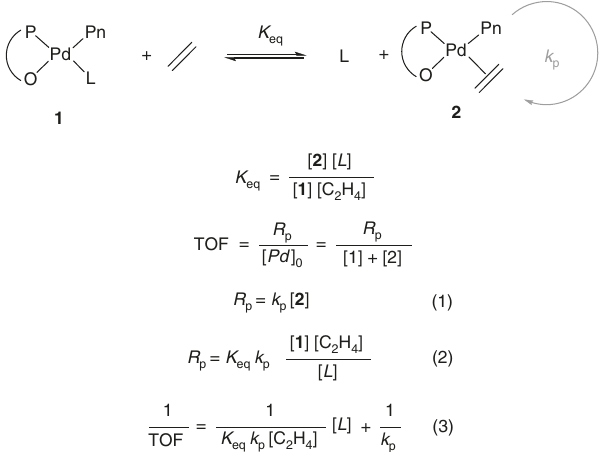
Fig. 5 Derivation of rate of polymerization assuming a fast and reversible pre-equilibrium. Equation (3) highlights the linear dependency of the inverse TOF as a function of the concentration of L a coordinating agent competing with ethylene. The slope of this line provides information on the equilibrium constant and rate constant of polymerization of the catalyst